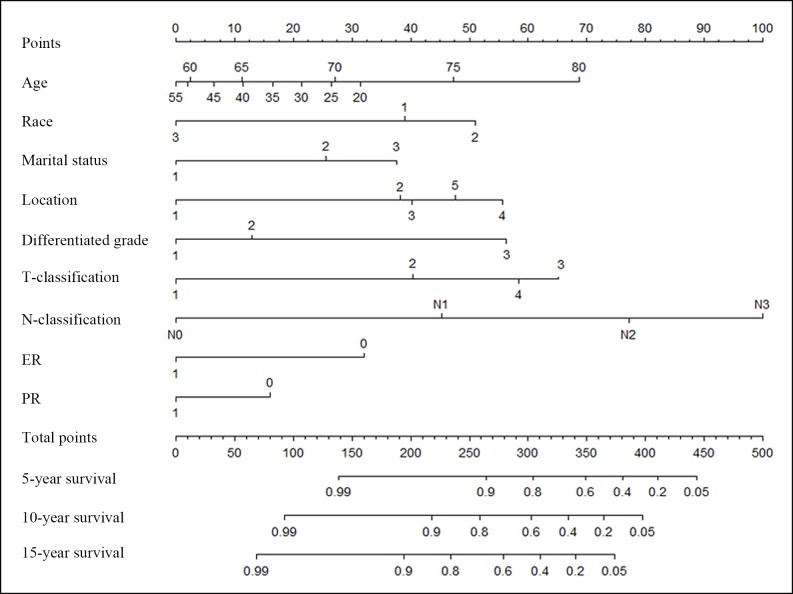
Nomogram for predicting the CSS of patients with MBC.The nomogram is used by summing the points identified on the top scale for each independent covariate. The total points projected to the bottom scale indicate the % probability of the 5-, 10-, and 15-year survival. Race: 1 = white, 2 = black and 3 = other; Marital status: 1 = married; 2 = single (never married or having a domestic partner) and 3 = divorced (separated, divorced, or widowed). Location: 1 = central portion of the breast, 2 = upper-inner quadrant of the breast, 3 = lower-inner quadrant of the breast, 4 = upper-outer quadrant of the breast and 5 = lower-outer quadrant of breast. T and N-classification according to the 7th AJCC TNM system. ER = estrogen receptor: 1 = positive and 0 = negative. PR = progesterone receptor: 1 = positive and 0 = negative. CSS: cancer specific survival and MBC: mucinous breast cancer.